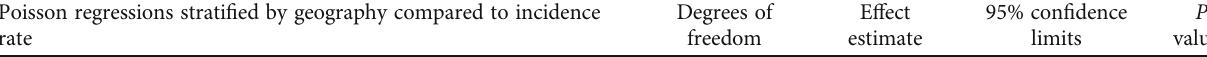
Association between zonal hospitals and EC IR without eastern zone